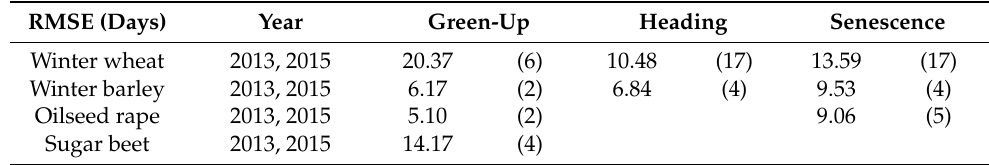
Table 4. RMSE in days between senescence, heading and green-up dates calculated using homogeneous MODIS pixels and field data (DWD and UFZ) for different crops in 2013 and 2015. The corresponding number of field observations for validation is given in brackets. RMSE (Days) Green-Up Heading Senescence